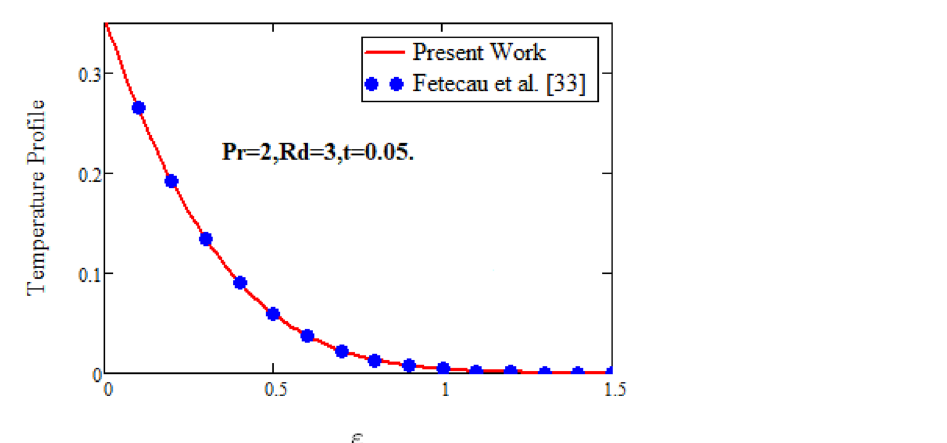
Figure 12. Comparative study of velocity profiles.